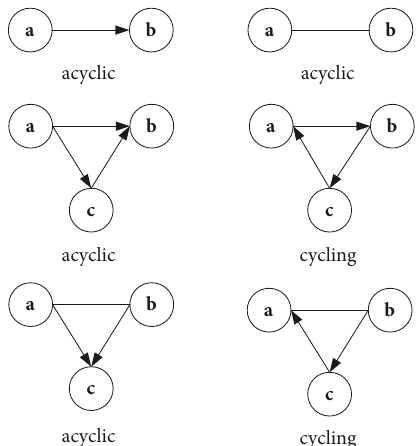
Figure 10: Rules to judge the feasibility of hybrid